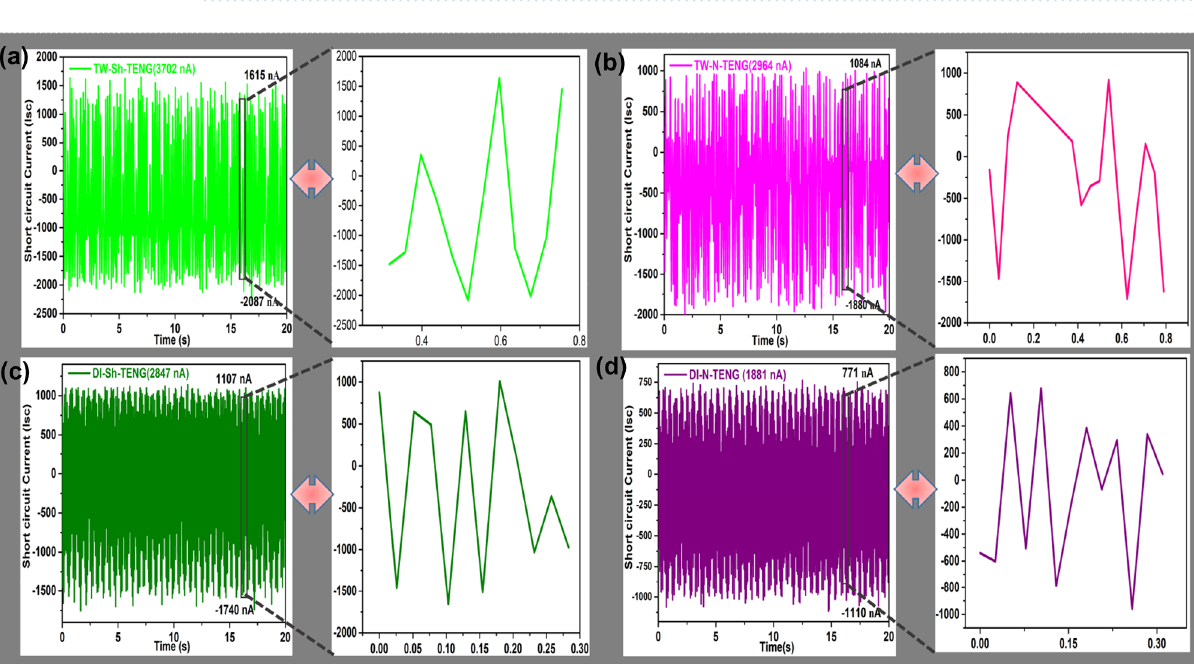
Figure 8. The short-circuit current (I sc ) of ( a ) TW-Sh-TENG; ( b ) TW-N-TENG; ( c ) DI-Sh-TENG; ( d ) DI-N- TENG and their single to three pulsatile open-circuit voltages (V oc ) showed in the inset